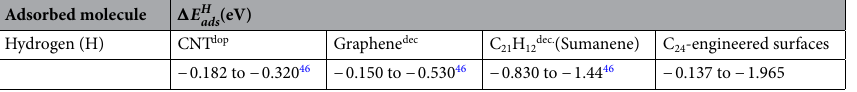
Adsorbed molecule